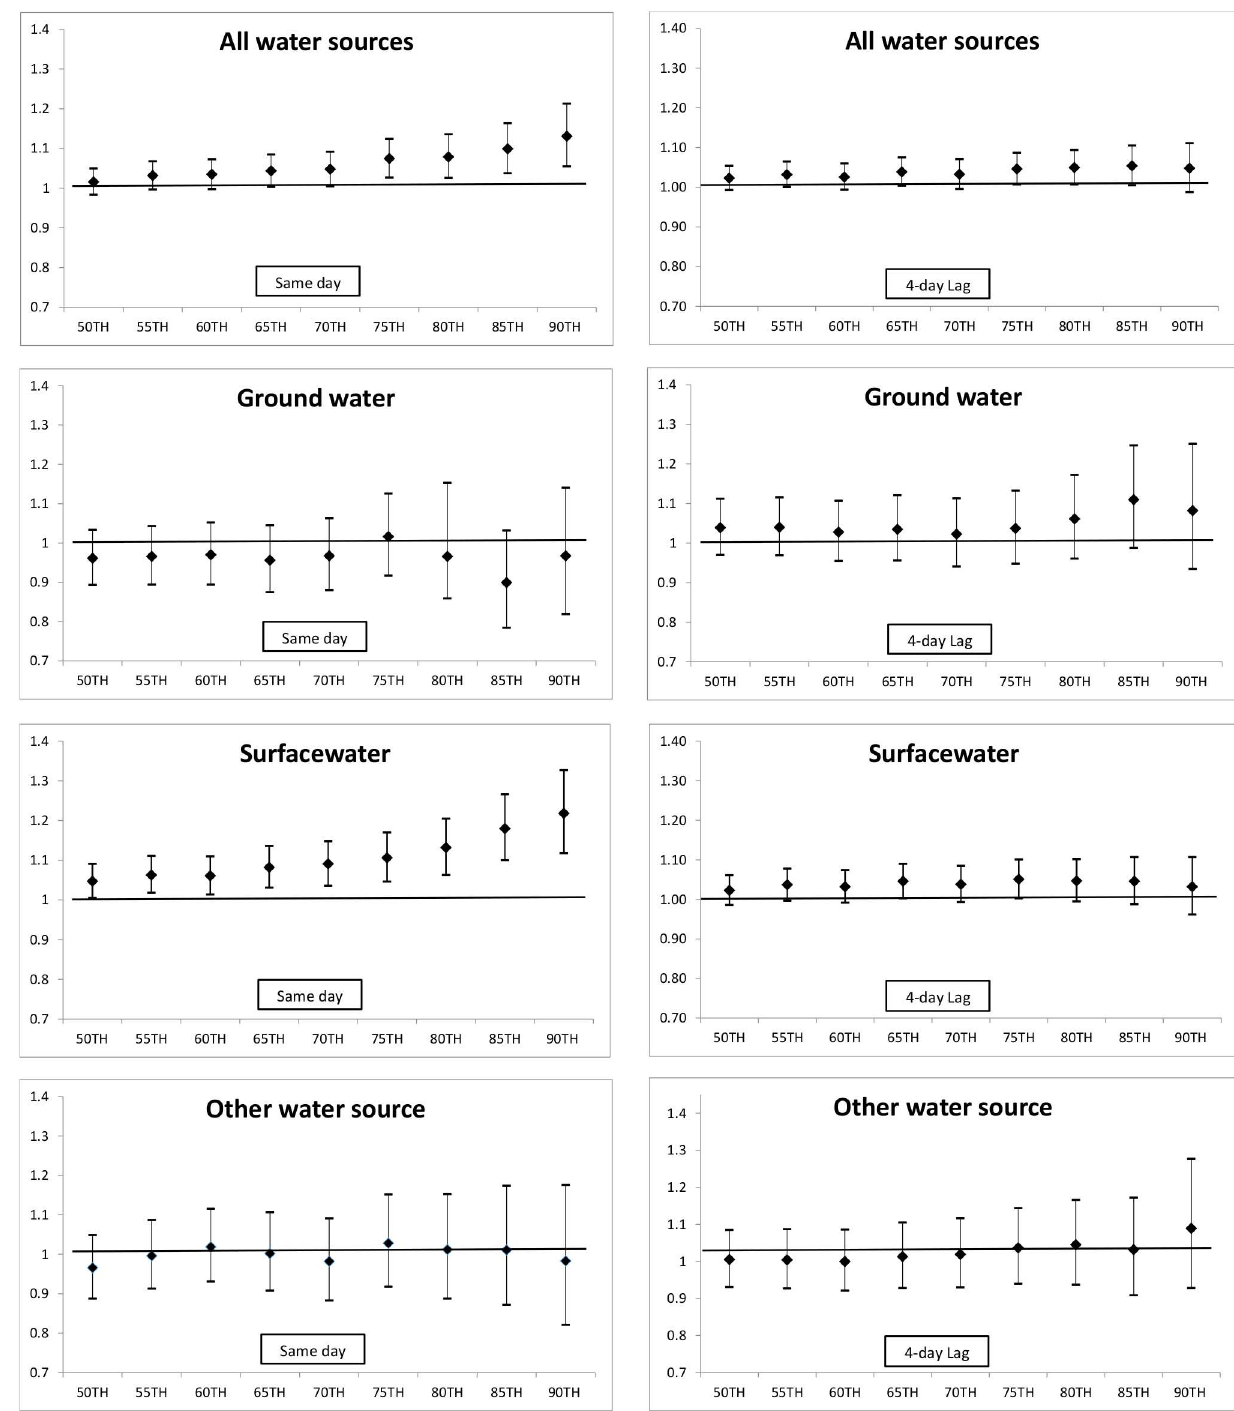
Fig 1. Threshold analysis of odds ratios and 95% confidence intervals of 50 th percentile compared to each increasing 5 th percentile of precipitation overall and for groundwater, surfacewater, and ‘Other’ water source for sameday and 4-day lag precipitation during the warm